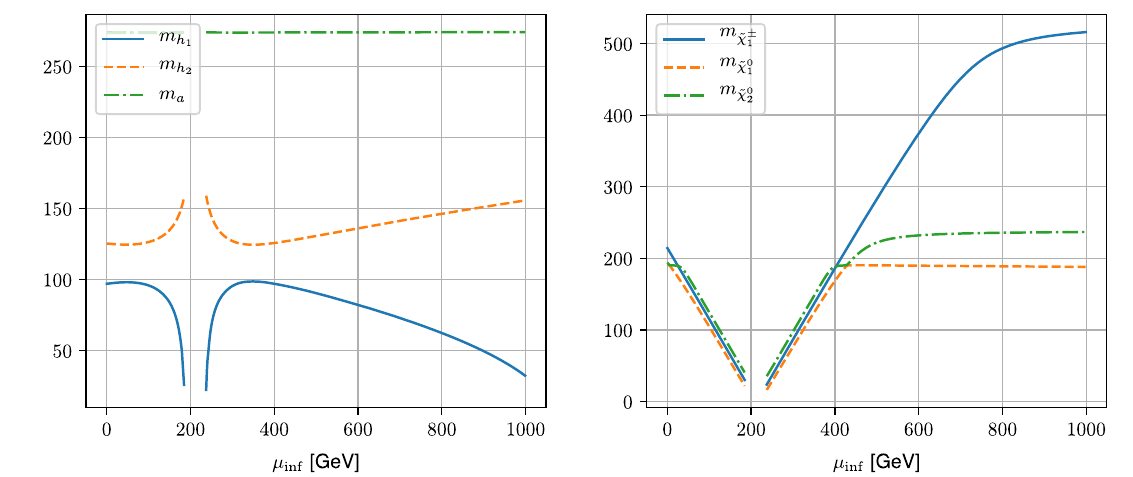
Fig. 1 The masses of scalar higgses h 1 , h 2 , pseudoscalar higgs a , neutralinos ˜ χ 0 Fig. 2 The three mixing components of two lightest Higgs bosons depending on μ inf . From bottom to top: the down type components are | S 2 | 2 , the up type components | S 21 are | S 12 | 2 and | S 22 | 2 , and the singlet components are | S 13 | 2 and | S 23 |